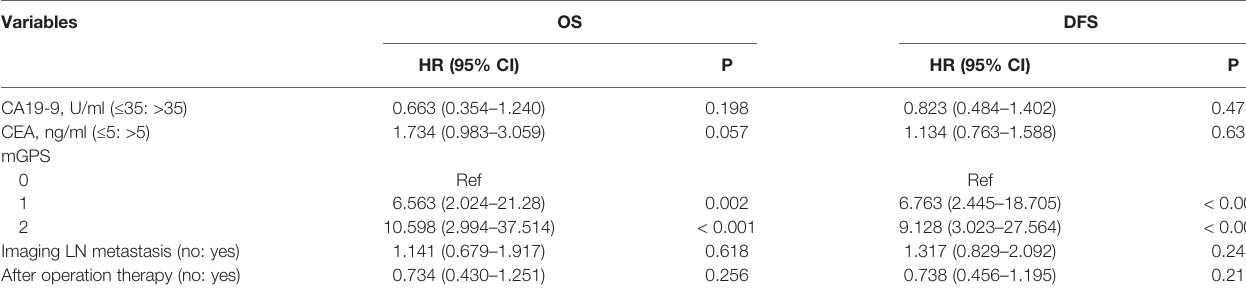
TABLE 4 | External validation of signi fi cant prognostic factors in primary cohort. Variables